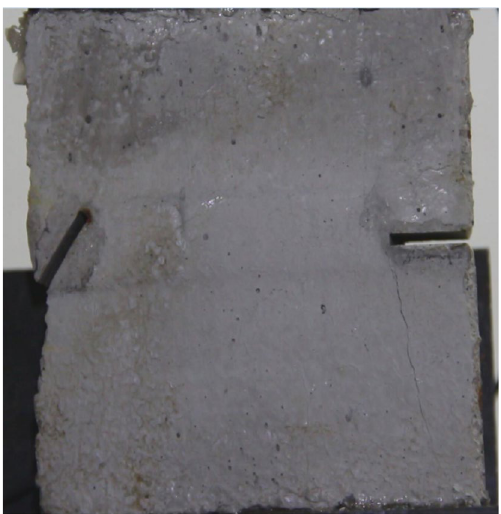
Figure 18. Photograph of a specimen showing tensile wing crack appearing.